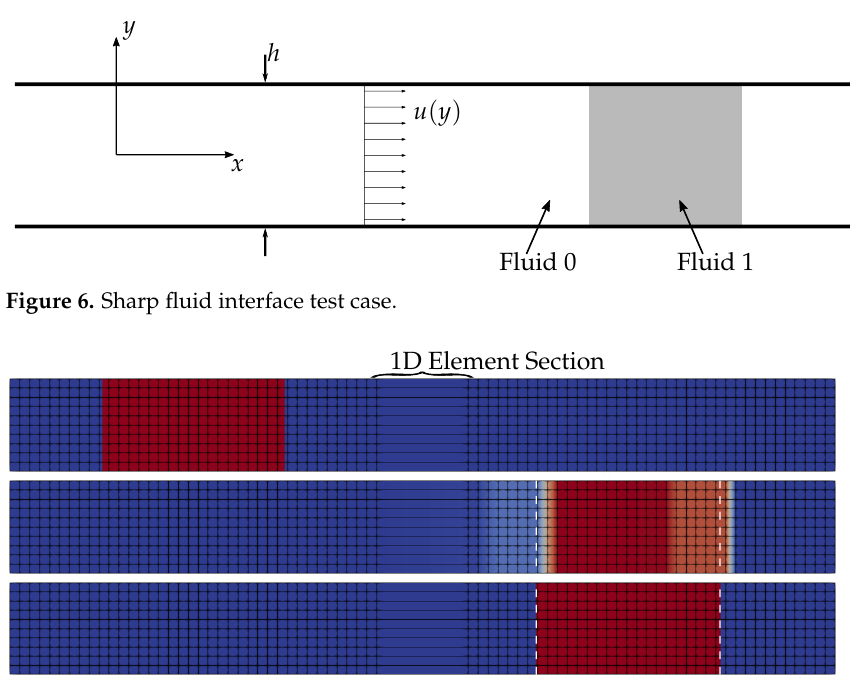
Figure 7. Fluid interface plot before Fluid 1 (red) traveled through the one-dimensional orifice elements ( top ). Fluid interface plot after Fluid 1 (red) traveled through the one-dimensional orifice elements without ( middle ) and with ( bottom ) the changes to